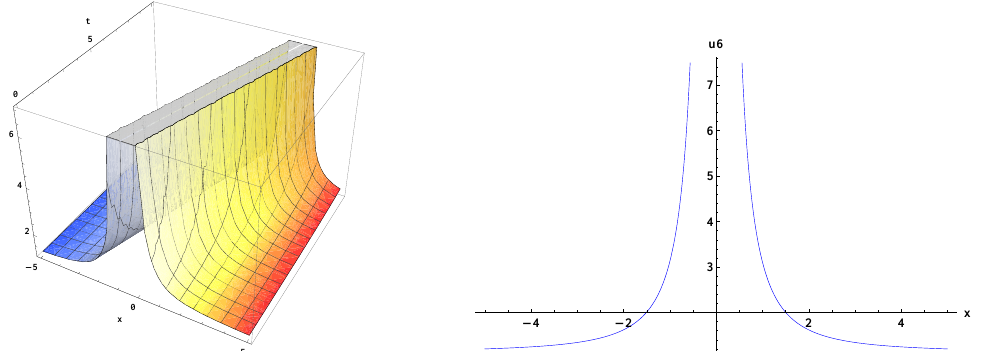
Figure 6. Singular solitary wave solution (20) ( left ) and its projections at t = 0 ( right ), when a = 1, c = 1, δ = 1, k = 0.3, b = 2, and y = 0.5.